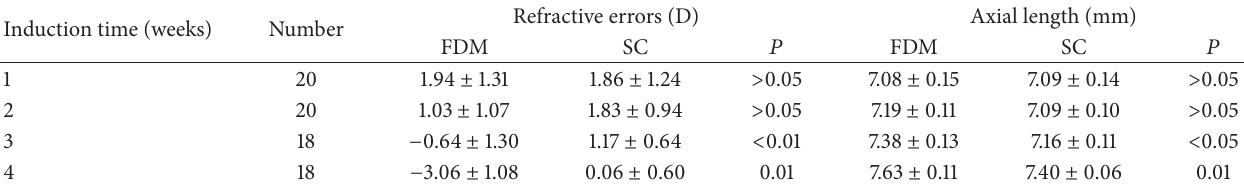
Table 1: The refractive errors and axial length in FDM group and SC group.